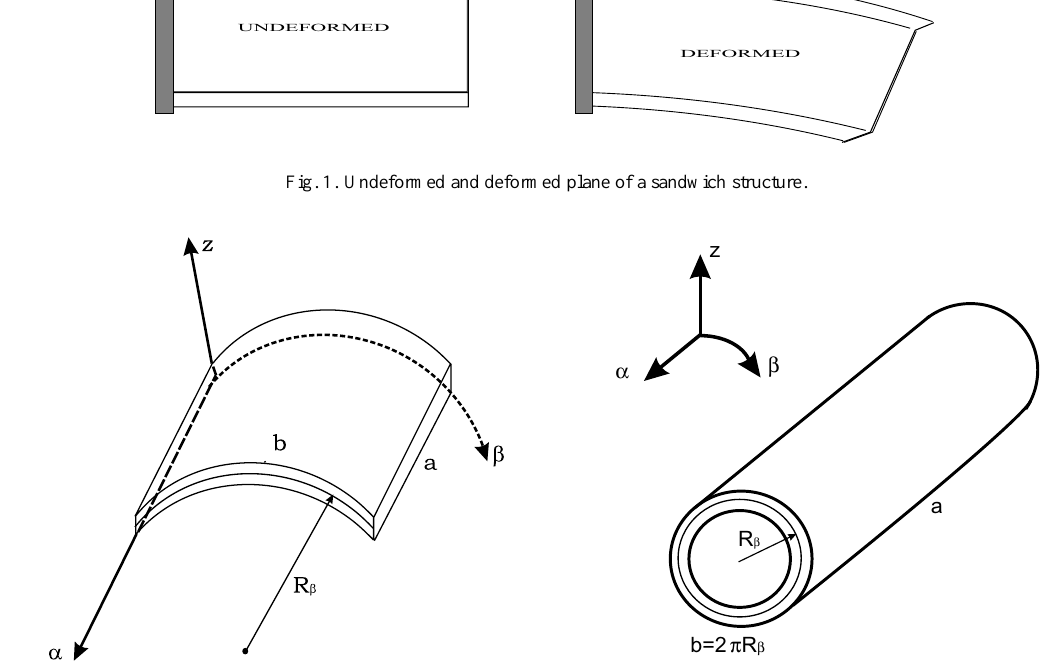
Fig. 2. Geometry and notations for the Ren (left) and the Varadan and Baskar (right)